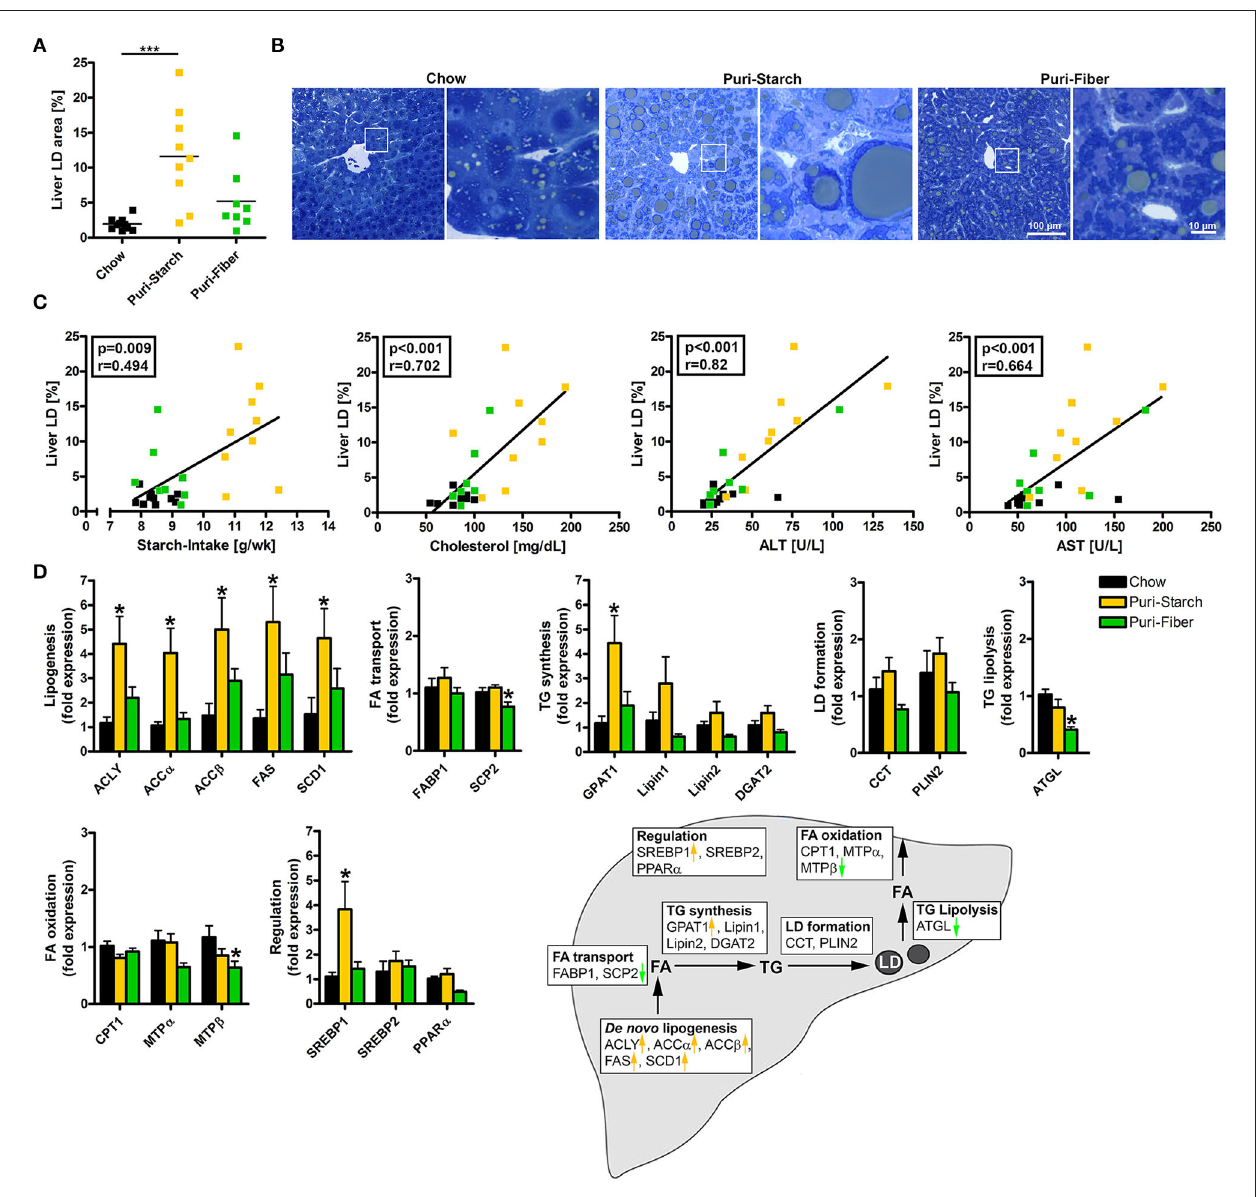
FIGURE 3 | Effects of diets on hepatic lipid accumulation and liver lipid metabolism. (A) Percentage of area occupied by lipid droplets in the liver. Data are shown as individual data points with indicated means, *** p < 0.001 (one-way ANOVA and Tukey post-hoc test). (B) Representative images of liver sections stained with toluidine blue, enlargements of indicated regions shown next to the overviews. (C) Correlations of liver lipid droplet area and (i) mean starch-intake averaged over 30 weeks, (ii) plasma cholesterol concentration after 30 weeks, (iii) plasma ALT concentration after 30 weeks, and (iv) plasma AST concentration after 30 weeks. Data are shown as individual data points with indicated linear regression ( p -values from Spearman correlation analysis and Pearson correlation coefficient given in rectangles). Chow n = 10, Puri-starch n = 9, and Puri-fiber n = 8. (D) mRNA expression levels of proteins implicated in hepatic liver metabolism. Data are shown as mean ± SEM, * p < 0.05 compared with Chow (one-way ANOVA and Tukey post-hoc test). Chow n = 8, Puri-starch n = 9, and Puri-fiber n =